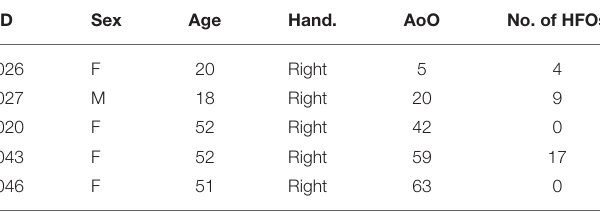
TABLE 2 | Control